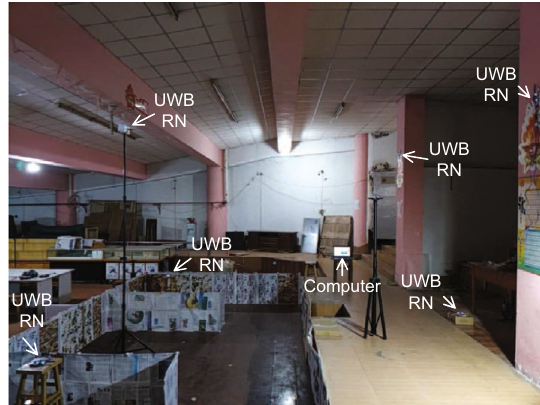
Fig. 4 The test environment